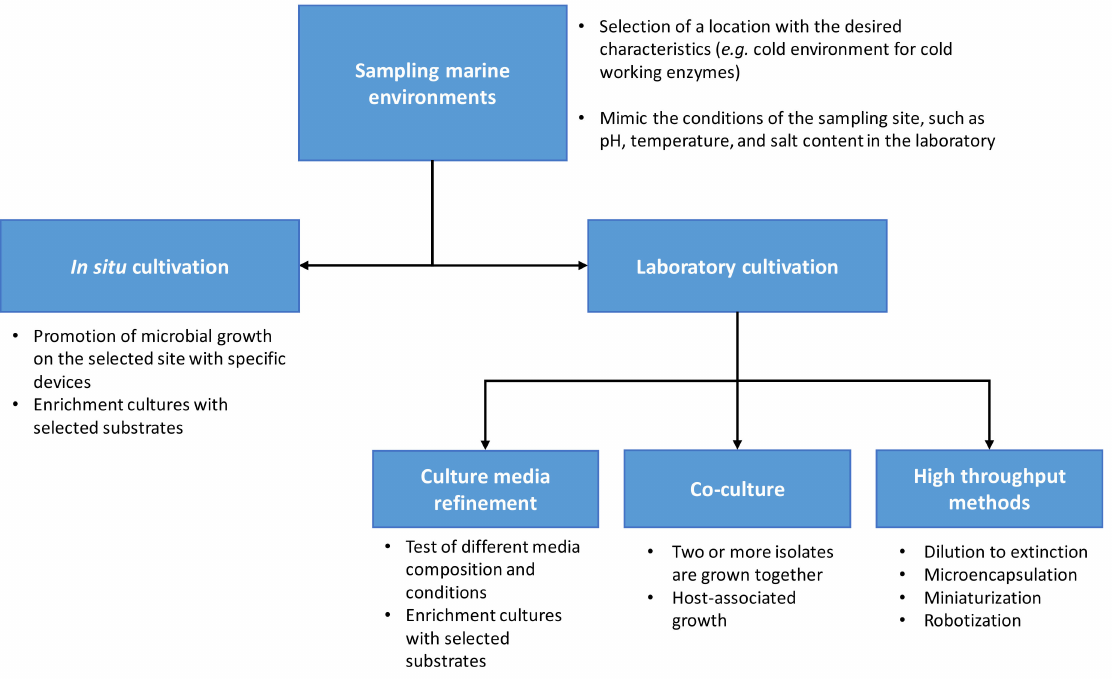
Figure 1. New cultivation approaches for isolation of microbial species from marine